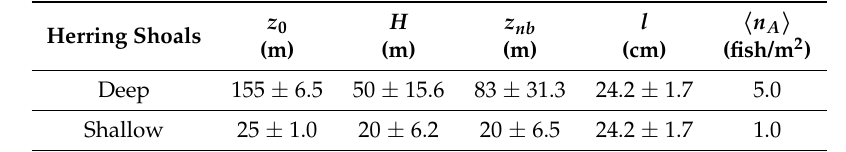
Table 2. Parameters of herring